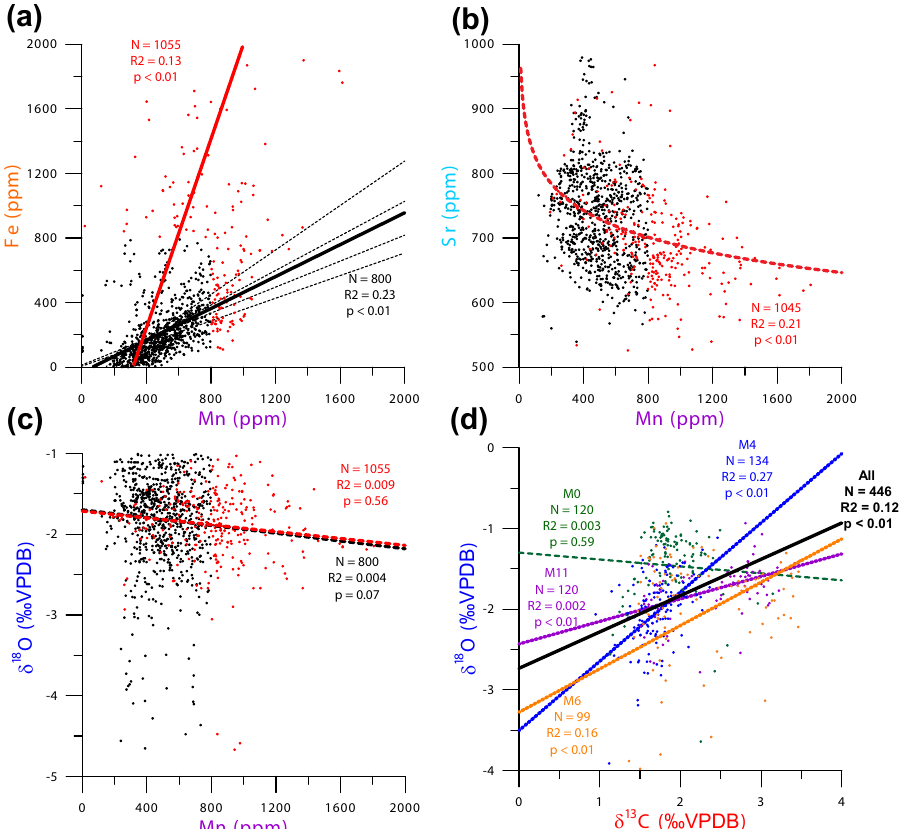
Figure 6. Cross plots between trace element and stable isotope measurements in the shells. Black lines indicate correlations through all measurements, red lines show correlations of diagenetically altered samples (according to the 800µgg − 1 threshold for Fe and Mn) and alternatively coloured lines indicate correlations in individual shells. Statistics of the regressions are indicated in matching colours. (a) Fe vs. Mn showing a correlation between concentrations of these elements in all shells. Steeper slopes suggest relatively more Fe is added in diagenetically altered samples. (b) Sr vs. Mn showing decreasing Sr concentrations corresponding to increasing Mn, but only in diagenet- ically altered samples. No significant correlation was found for pristine samples ( R 2 = 0 . 11, p = 0 . 25). (c) δ 18 O vs. Mn showing lack of correlation. (d) δ 18 O vs. δ 13 C, showing positive correlation in specimens affected by diagenesis and no correlation in M0, which has pristine